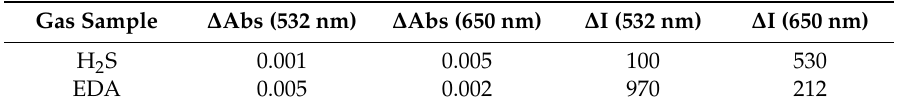
Table 1. Absorbance changes ( ∆ Abs = | Abs gas − Abs film | ) and responses ( ∆ I) of the Nf-TNPP sensor upon exposure to H 2 S and EDA at different laser-beam wavelengths.